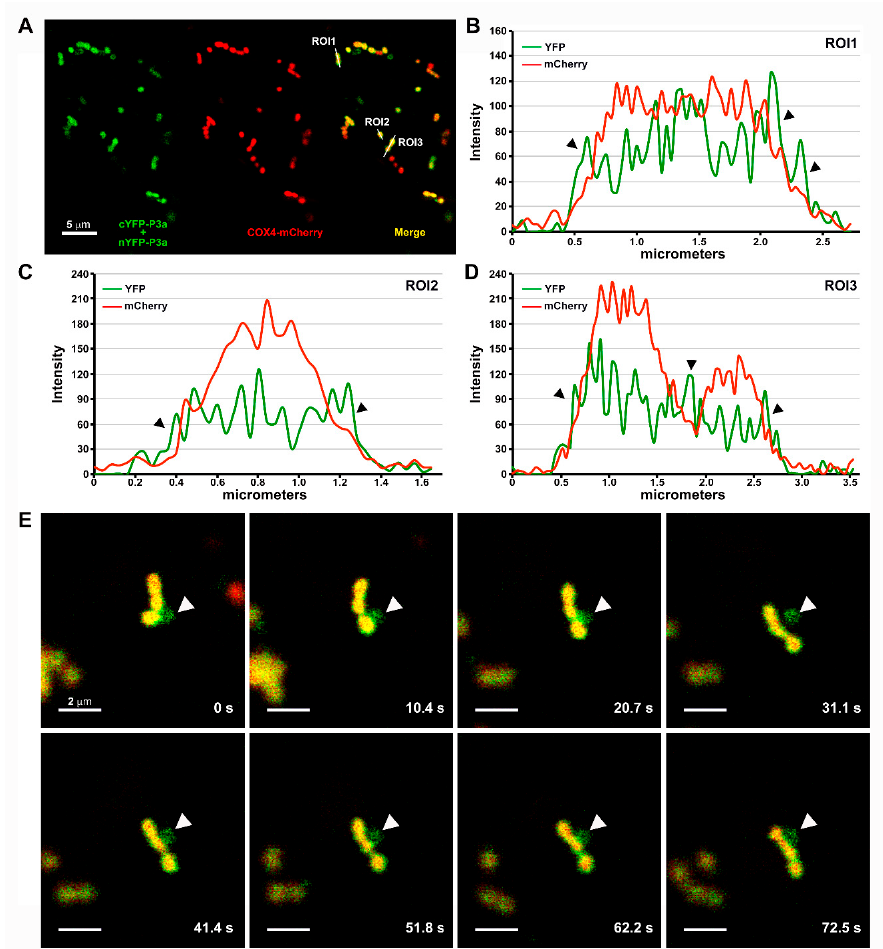
Figure 6. The N-terminally-tagged P3a homodimer localizes to mitochondrial outer membranes and mitochondrial-derived vesicles (MDV). ( A ) A single-plane confocal micrograph montage of a leaf epidermal cell co-expressing the bimolecular fluorescence complementation (BiFC) constructs described in Figure 5; ( B – D ) Line graphs show the fluorescence intensities of YFP and mCherry measured every 0.04 micrometers across the region of interests (ROI) highlighted by the white lines in panel A. Black arrowheads indicate a region where YFP fluorescence is increased over mCherry fluorescence at the edges of mitochondria; ( E ) A merged time-course analysis of an N. benthamiana leaf epidermal cell co-expressing cYFP-P3a, nYFP-P3a, and COX4-mCherry (red) shows the association and disassociation of a BiFC YFP fluorescent (green) vesicle from a COX4-mCherry labeled mitochondria. Yellow indicates co-localization of YFP and mCherry fluorescence. The panels are representative, single-plane confocal images from Movie S8. The time stamp is in seconds (s).